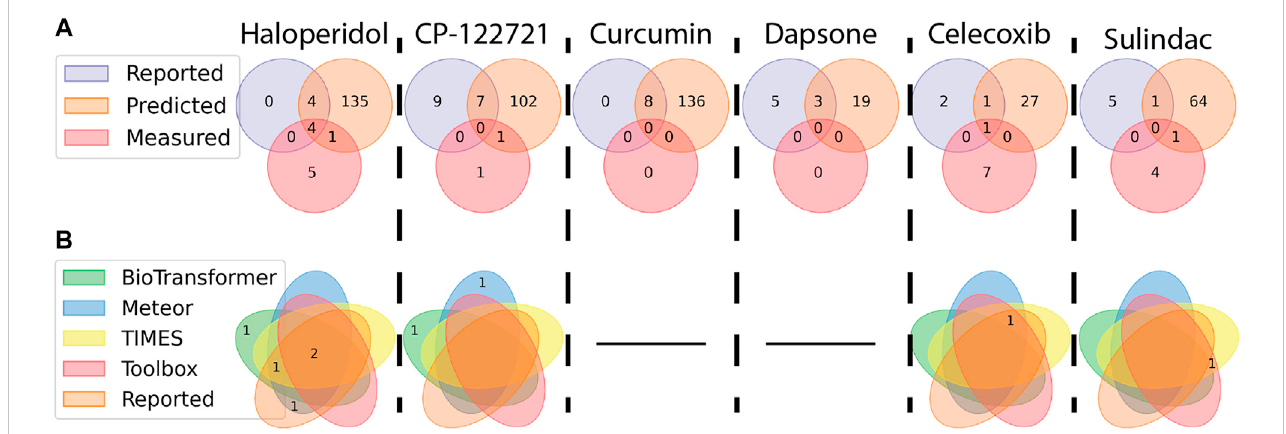
FIGURE 7 Venn diagrams showing the distribution and similarity of metabolites identi fi ed from different sources. Numbers indicate how many metabolites match theconditions ofeachellipse. (A) Similarity ofmetabolites arecomparedbetweenfeaturesmeasuredusing theNTA methodoutlinedinthiswork,reportedin literature, and predicted by in silico tools. (B) Metabolites identi fi ed as part of the NTA were separated based on the source of the structure (a black line indicatesnometaboliteswereidenti fi ed via theNTA).TakingHaloperidolforexample,fourmetaboliteswerereportedintheliterature,predicted insilico , and observed. Another four metabolites were reported and predicted, but not observed. One previously unreported metabolite was predicted and